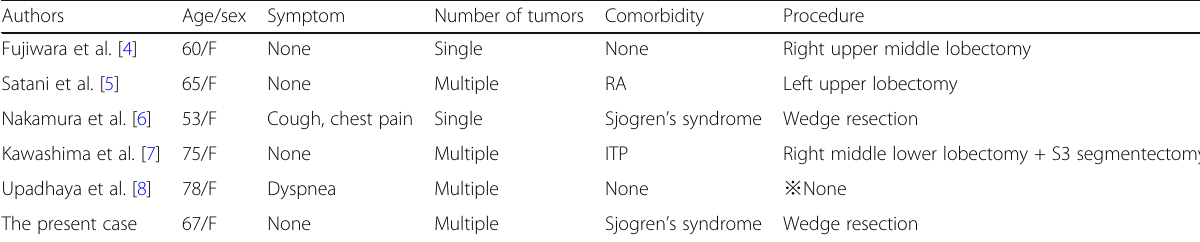
Table 1 Primary pulmonary mucosa-associated lymphoid tissue lymphoma with amyloid